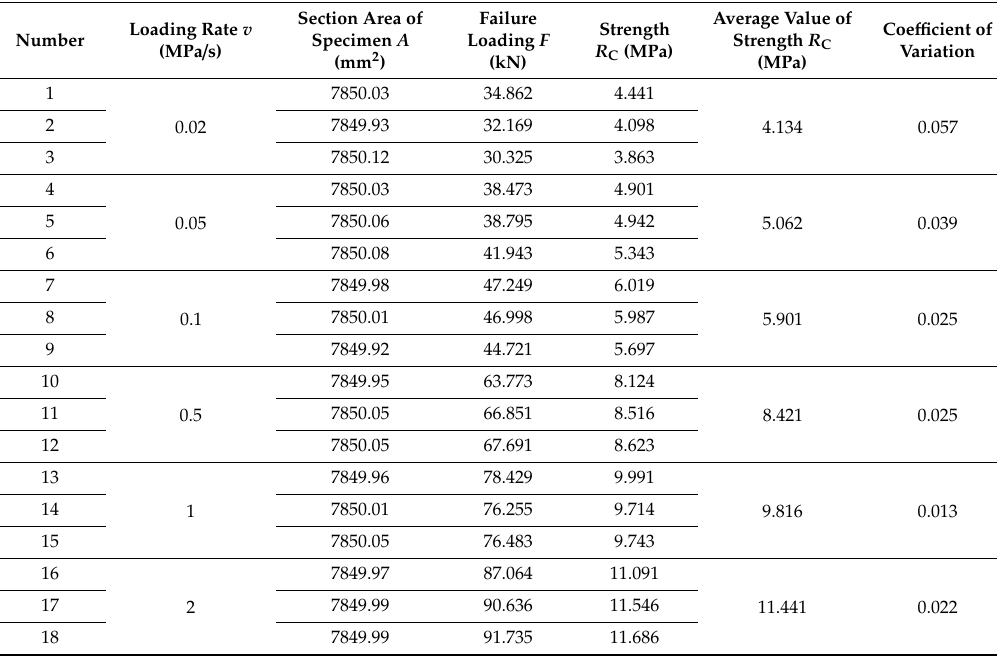
Table 7. Test results of unconfined compressive strength of asphalt